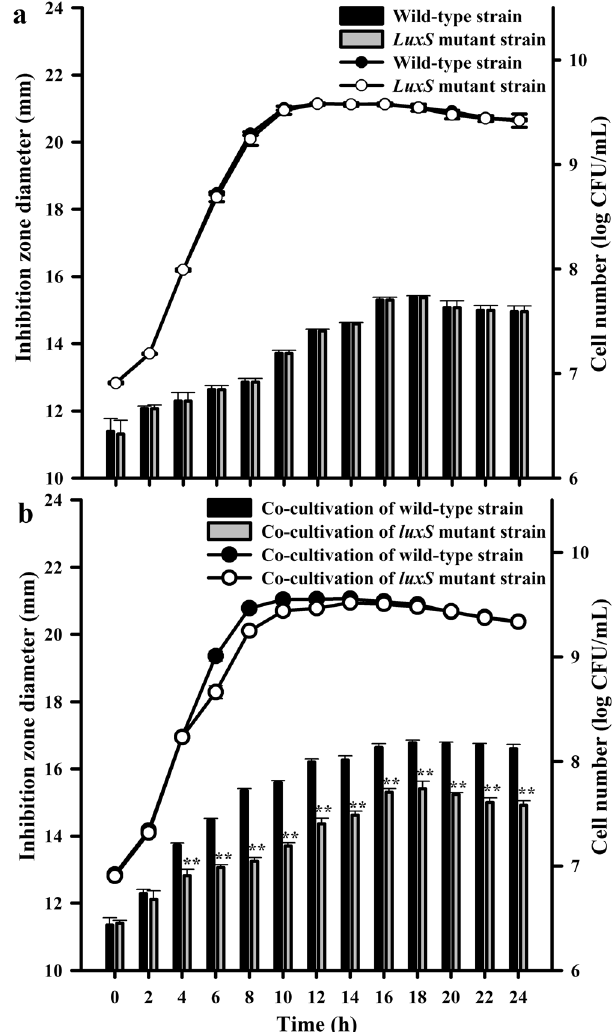
Figure 1. Cell number ( , ) and inhibitory activity ( , ) of wild-type and luxS mutant strains in mono-cultivation ( a) and co-cultivation with L. helveticus KLDS1.9207 ( b ). Cell number and inhibition zone diameter (inhibitory activity) are expressed as the means ± standard deviation (SD; n = 3). ** Statistically significant difference between wild-type strain and luxS mutant strain ( P <